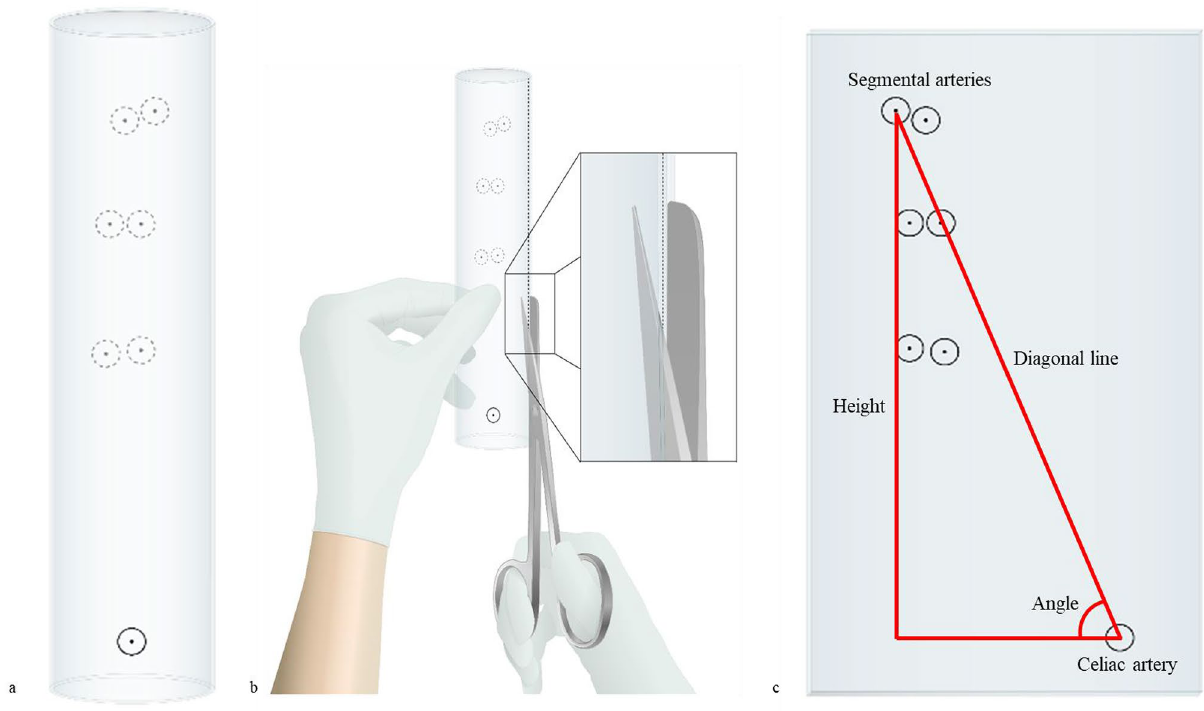
Figure 4. Guide to evaluating the accuracy of IBT and GBT; ( a ) Locating celiac artery and segmental arteries marked on graft. ( b ) Spreading the graft using scissors. ( c ) Measuring the length, height, and angle between celiac artery and segmental arteries.